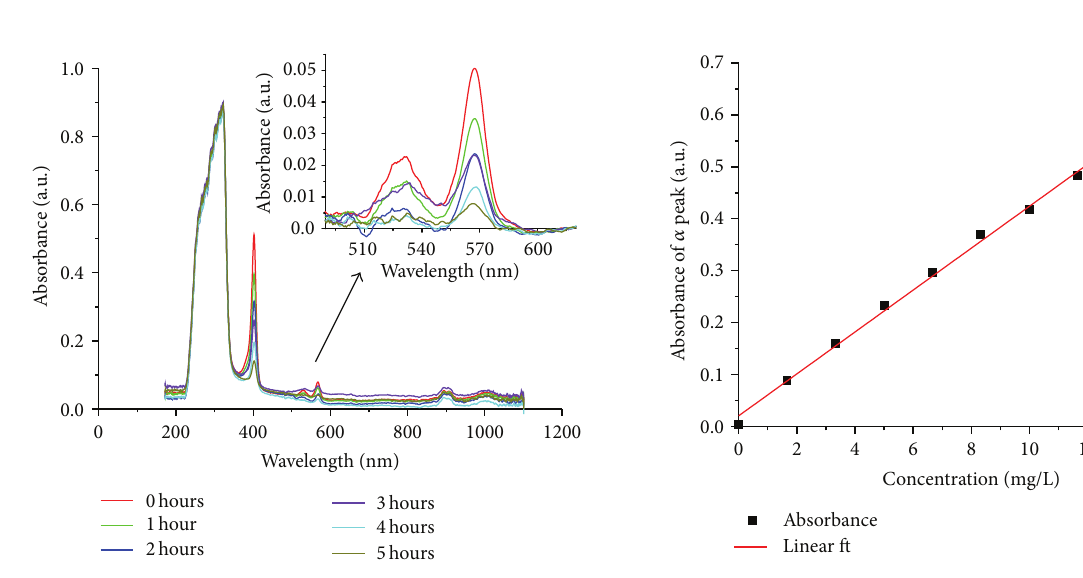
determined. Figure 8 shows the areas under the peaks versus the irradiation time. It can be seen that in all cases the 𝛼 and 𝛽 peaks disappear after several hours of irradiation, but that the time needed for this degradation process depends strongly on the presence of water, TiO 2 , and N-TiO 2 /Cu. As a general trend, it can be observed that the presence of water shortens the degradation time of the vanadium etioporphyrins, both for the measurements with and those without TiO 2 or N- TiO 2